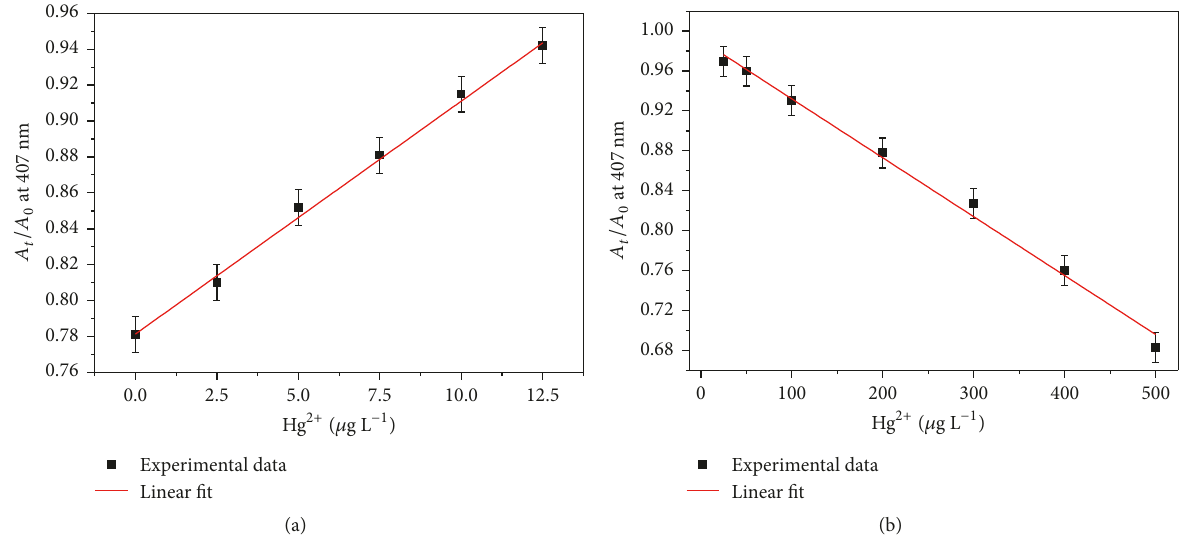
Figure 4: Plot of A / 𝐴 0 as a function of the Hg 2+ concentration over the ranges of (a) 0–12.5 𝜇 g L −1 and (b) 25–500 𝜇 g L −1 in the presence of t 0.005 mol L −1 HNO 3 .